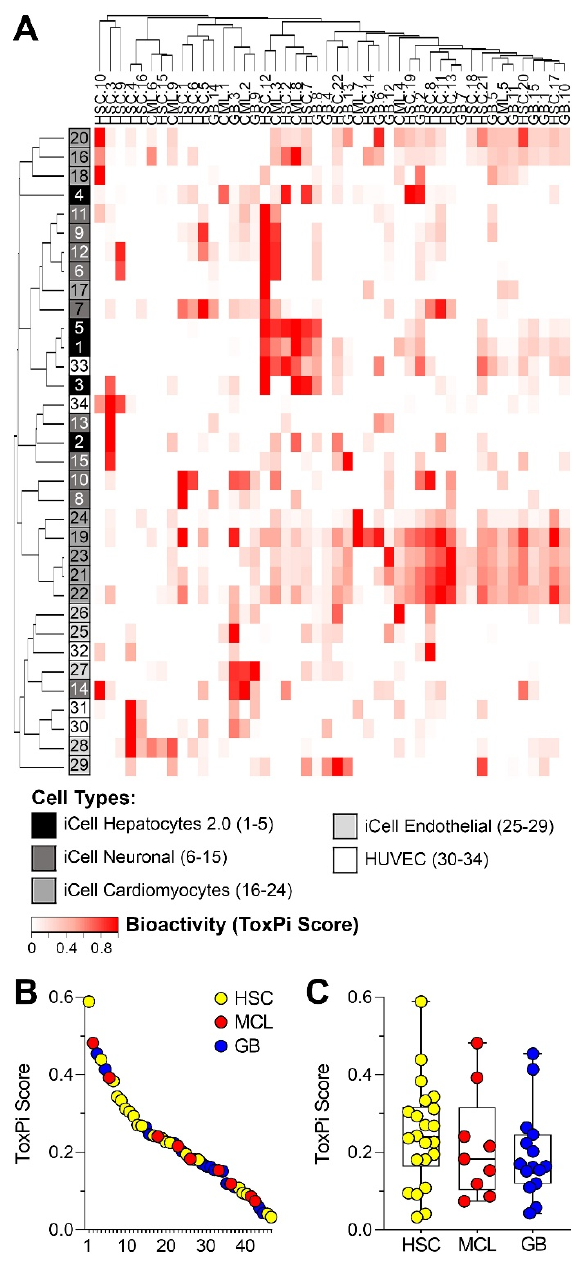
Figure 2. Biological profiles of sediment samples collected from the Houston Ship Channel (HSC), Mud and Clear Lakes (MCL), and Galveston Bay (GB). ( A ) Heatmap showing relative bioactivity of each sample (columns) in each cell type/phenotype (rows). Hierarchical clustering was used to organize rows and columns by similarity. See Supplementary File S3 for the data. ( B ) Ranking of the samples based on the overall ToxPi scores ranking of all samples. Samples from each study area are color coded as indicated in Figure 1. ( C ) Box and whiskers plots (line = mean, box = interquartile range and whiskers are min/max values) showing the distribution of the overall bioactivity ToxPi scores in each study area.